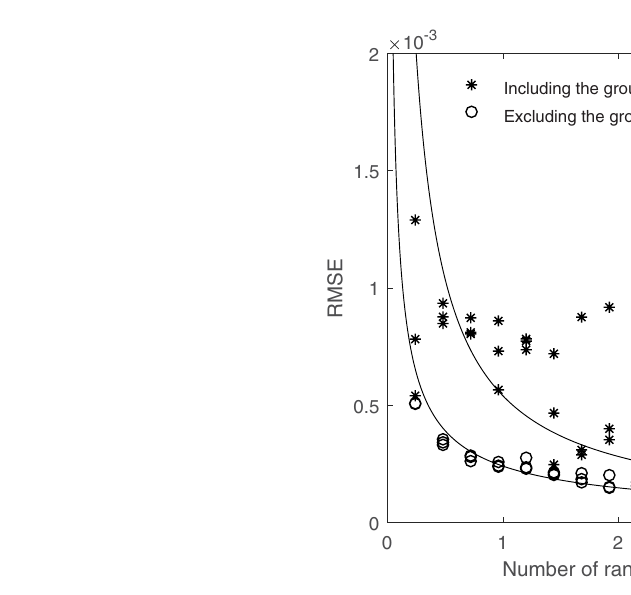
FIGURE 6 The relationship between the number of random points used and RMSE compared to using the whole area points, including and excluding the ground-peak region.